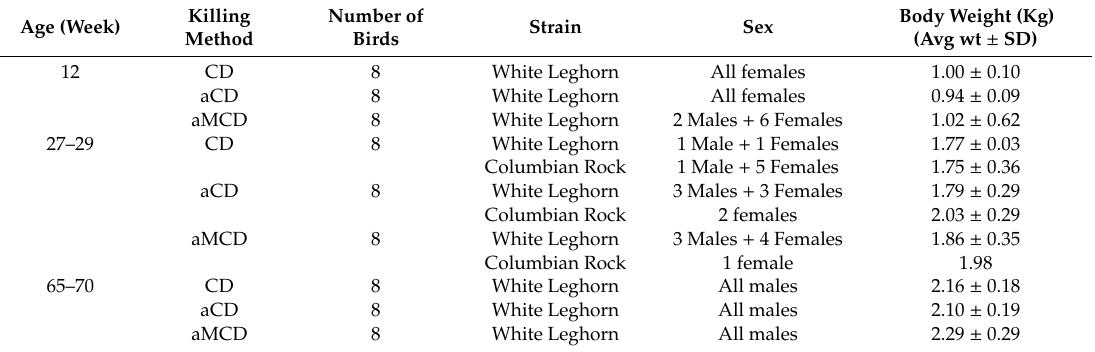
Table 1. Strain, sex, body weight, and sample sizes for the di ff erent age classes of birds used in the